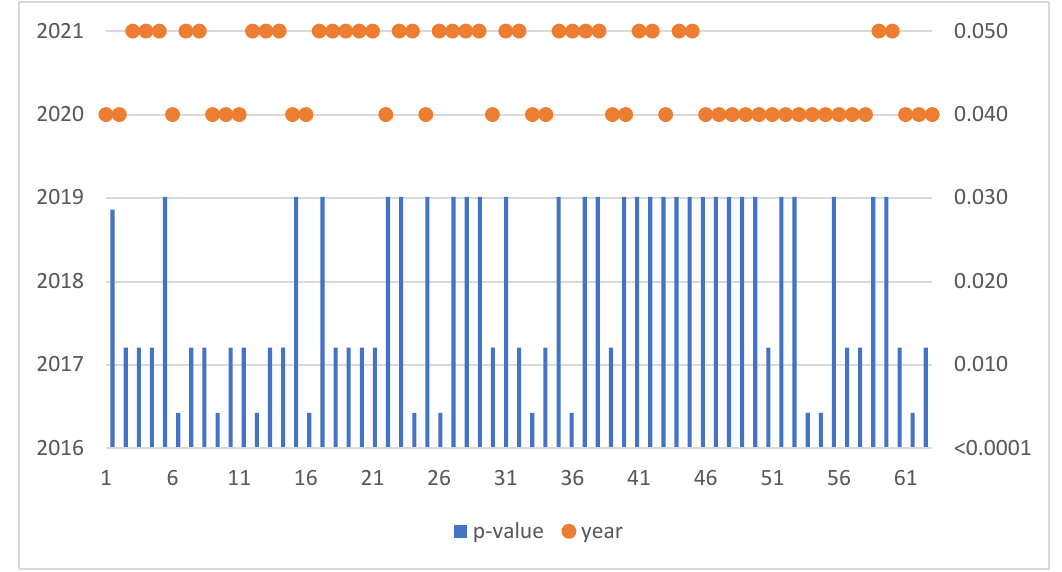
Figure 11. Heterogeneity in Poland.